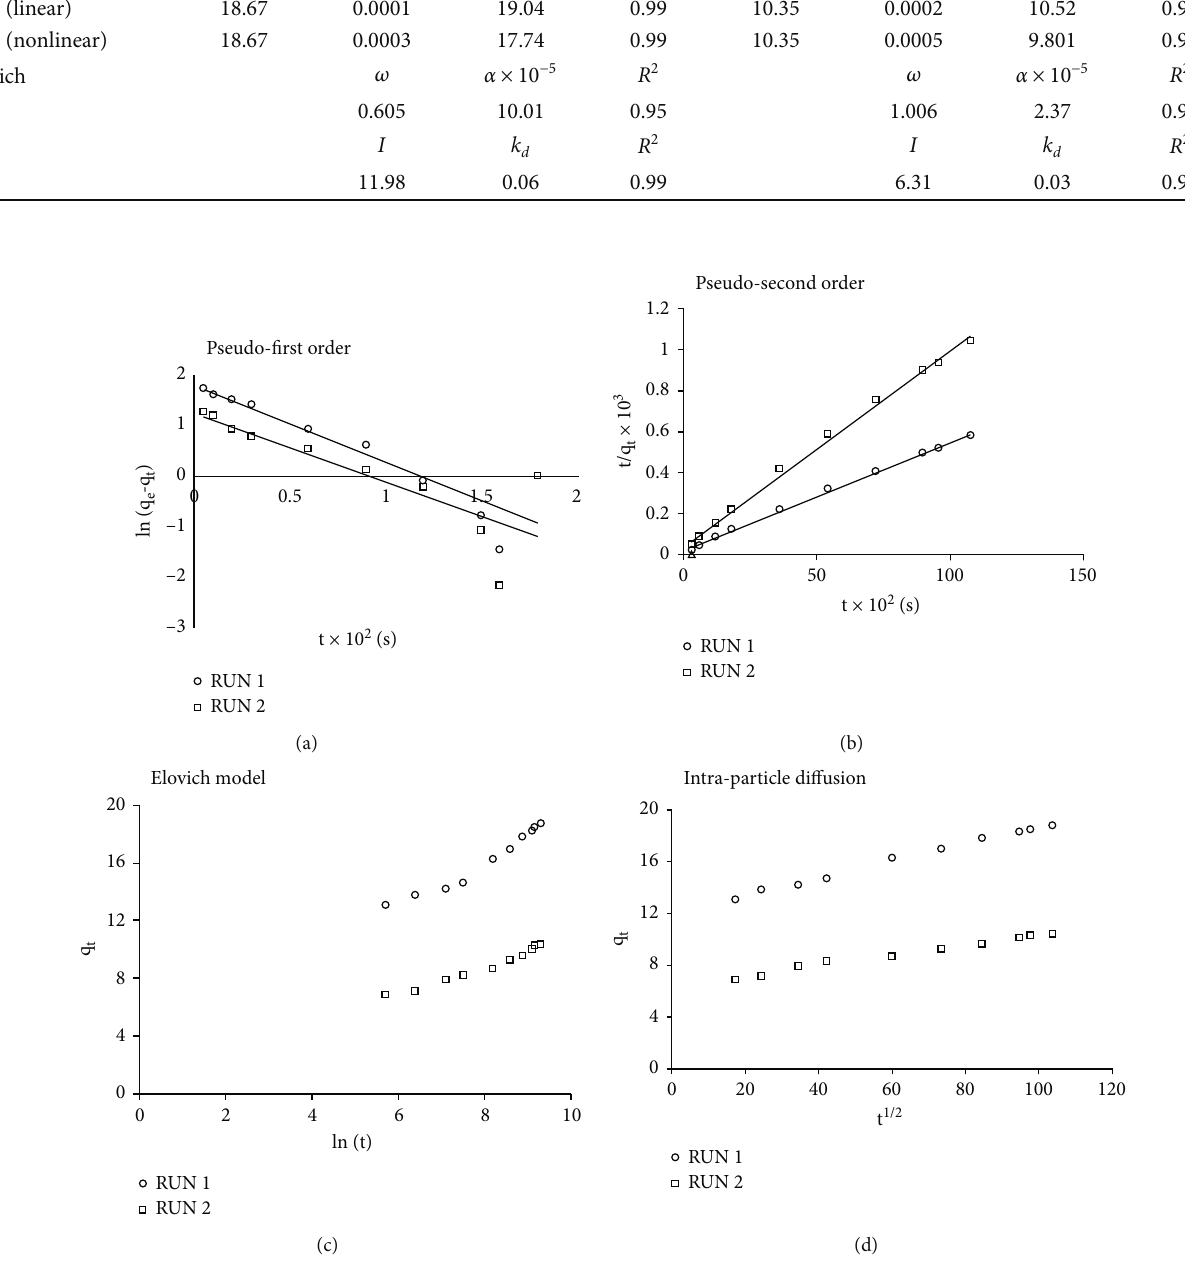
Figure 7: Linear plots of kinetic models for the adsorption of Congo red dye on breadfruit leaf biochar: (a) pseudo- fi rst-order (PFO), (b) pseudo-second-order (PSO), (c) Elovich model, and (d) intraparticle di ff